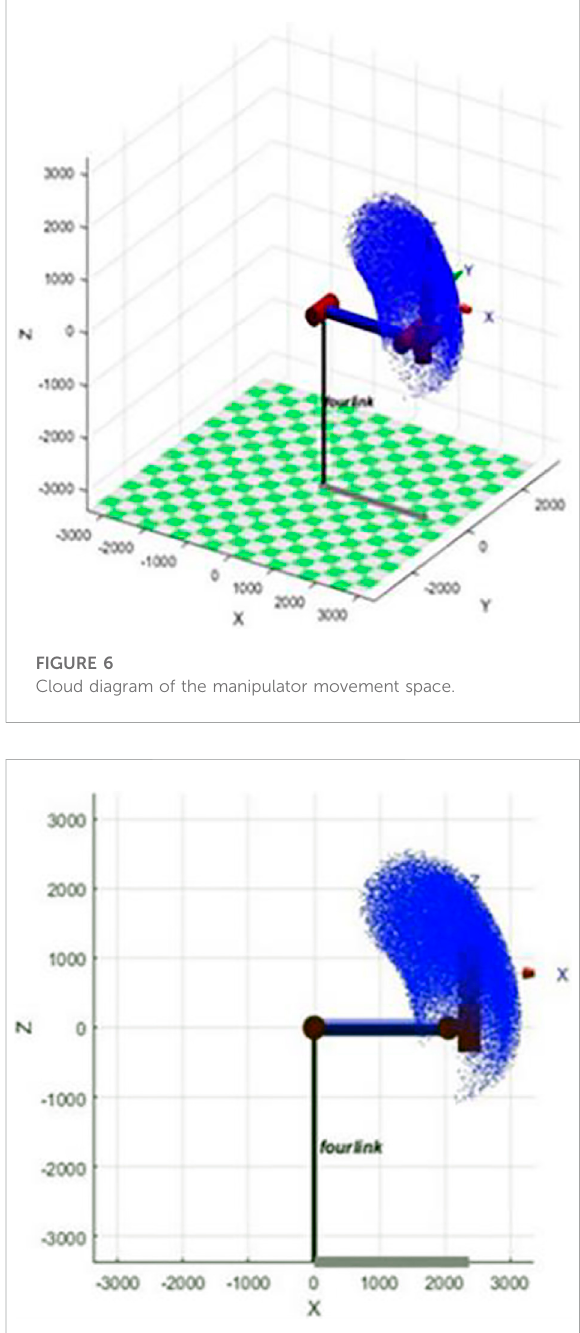
FIGURE 9 Cloud diagram of the ZOY plane motion